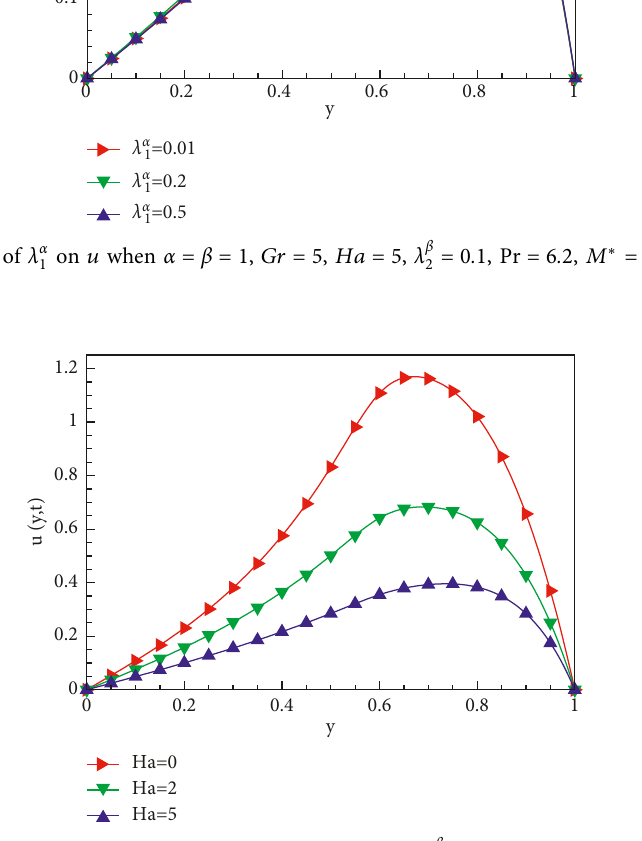
� 0 . 5 , Gr � 5 , λ β � 0 . 1 , Pr � 6 . 2 ,M ∗ � 0 . 5, and ϕ � 0 . 1. 2 1